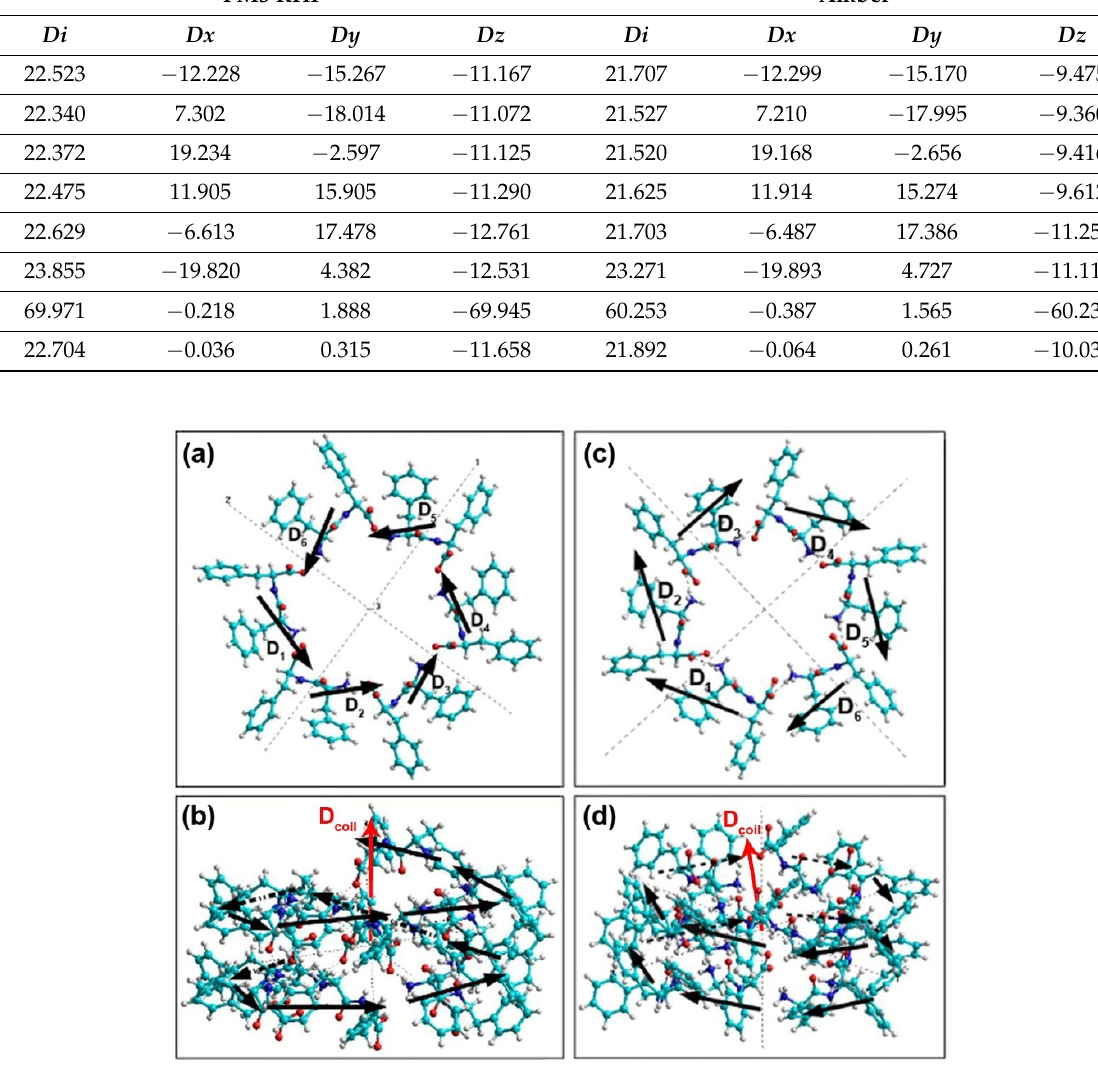
Figure 5. Schematic presentation of dipole moments D i in two coils of ( a , b ) L-FF and ( c , d ) D-FF PNTs: ( a , c ) Z-plane projection, ( b , d ) Y-plane projection. For L-FF PNT dipole moments form a right-hand helix, whereas for D-FF PNT form a left-hand helix. Red arrows show the directions of the total dipole moments of the coil D coil .